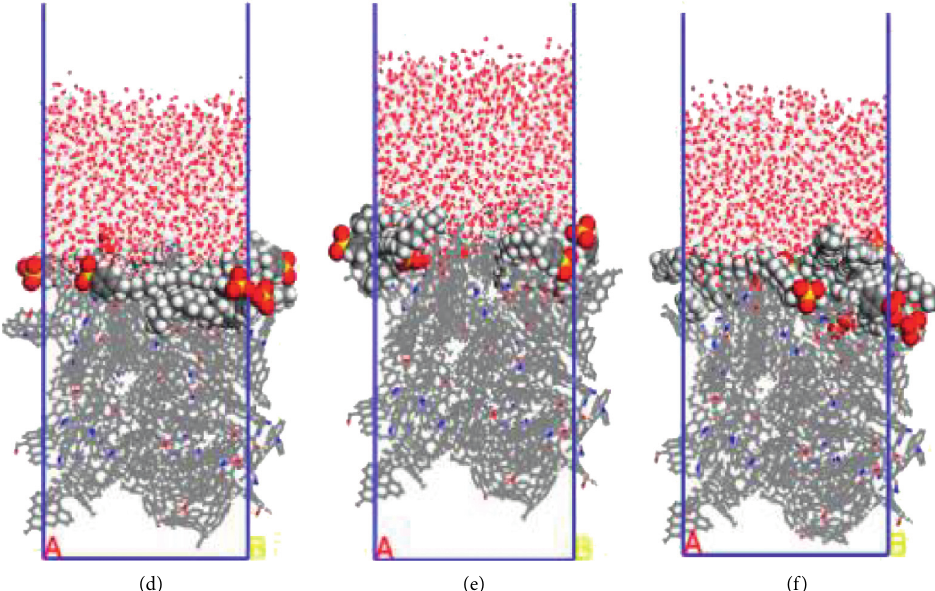
Figure 10: Equilibrium configuration of water-surfactant-anthracite system after MD simulation: (a) C8; (b) C10; (c) C12; (d) C14; (e)